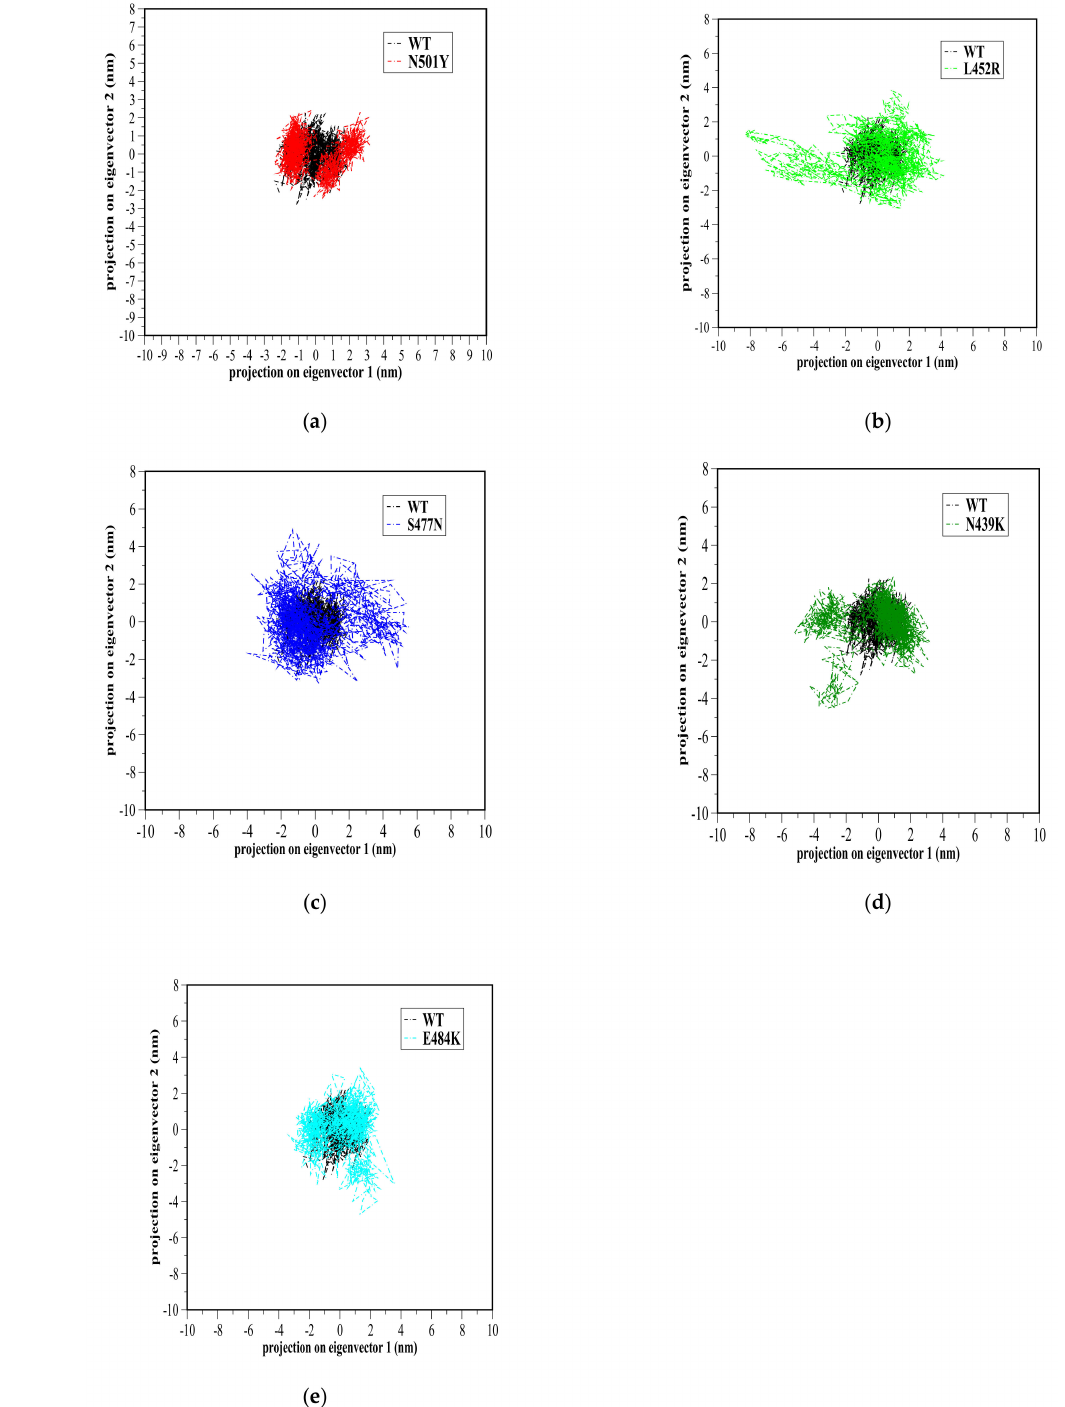
Figure 5. Projection of the motion of WT RBD (black color) aligned with either ( a ) N501Y (red color), ( b ) L452R (light green color), ( c ) S477N (blue color), ( d ) N439K (green color), or ( e ) E484K (cyan color) mutant receptor-binding domains (RBDs) along with the first two principal eigenvectors in